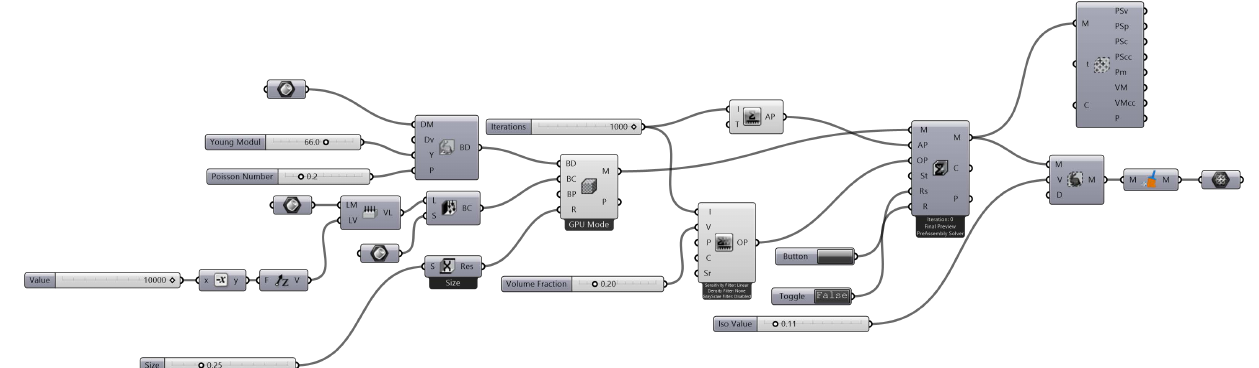
Figure 6. Bendsoe and Sigmund Grasshopper Workflow. A Bendsoe and Sigmund Optimisation on a 2.54 mm (height) and 2.54 mm (diameter) cylinder produced this result. The material used was BSH, and the loading was 100,000 kN under compression, as shown in Figure 7.